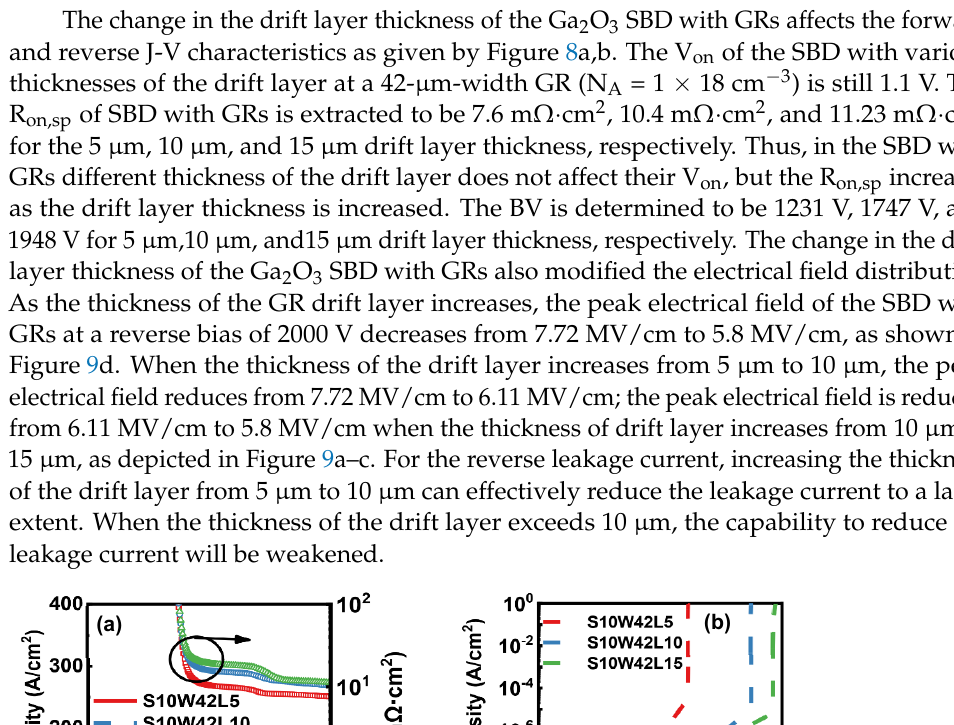
Figure 7. Electron barrier tunneling across the Schottky interface for Ga 2 O 3 SBD with a 10 ‐ μ mthick, 10 16 cm − 3 with ( a ) no GR, and ( b ) GRs at reverse bias of 500 V, when the doping concen ‐ tration of the NiO is 1 × 10 18 cm − 3 . ( c ) Electron barrier tunneling versus position for SBD with no GR and the GR width of 22 μ m, 37 μ m, 42 μ m, at − 500 V along the cutlines shown in the contour plots.